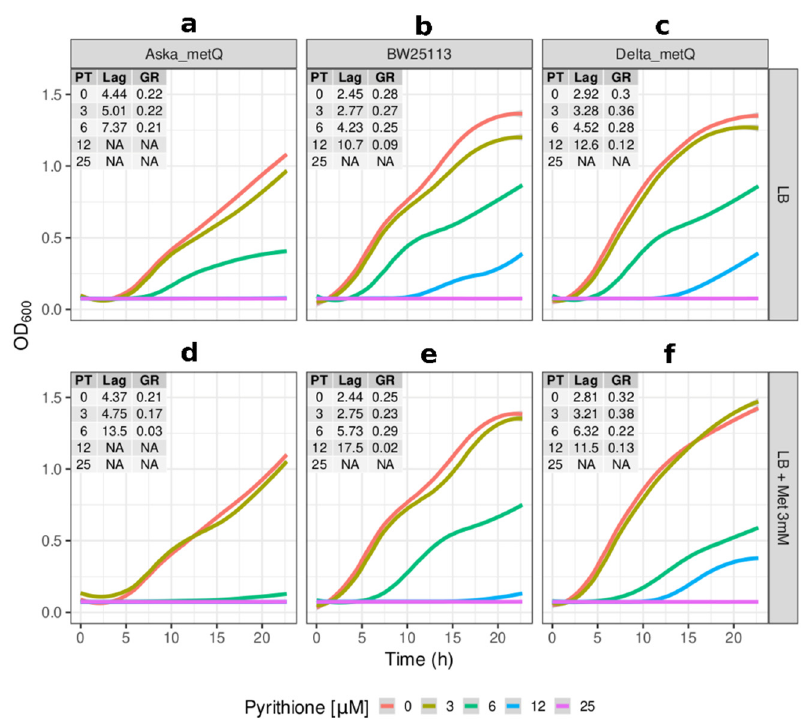
Figure 4. Effects of MetQ in the sensitivity of E. coli to pyrithionine. ( a – c ) Growth (OD 600 ) at incremental concentrations of pyrithione in complex media (LB) of the Aska strain carrying an episomal copy of metQ (Aska_metQ) ( a ), the reference strain E. coli BW25113 ( b ); and the Keio strain of the metQ knockout ( Delta_metQ ) ( c ). ( d – f ) As above with the addition of methionine at 3 mM final concentration. Insets: PT: concentration of pyrithione in micromolar (µM), Lag: length of lag phase in hours, GR: growth rates fitted from optical densities of the cultures in exponential phases with the parametric non-linear method of least squares. The colour coded lines represent the fitted data for cultures under the given concentrations of pyrithione in micromolar (µM) units. NA (non-applicable): data below detection limit.